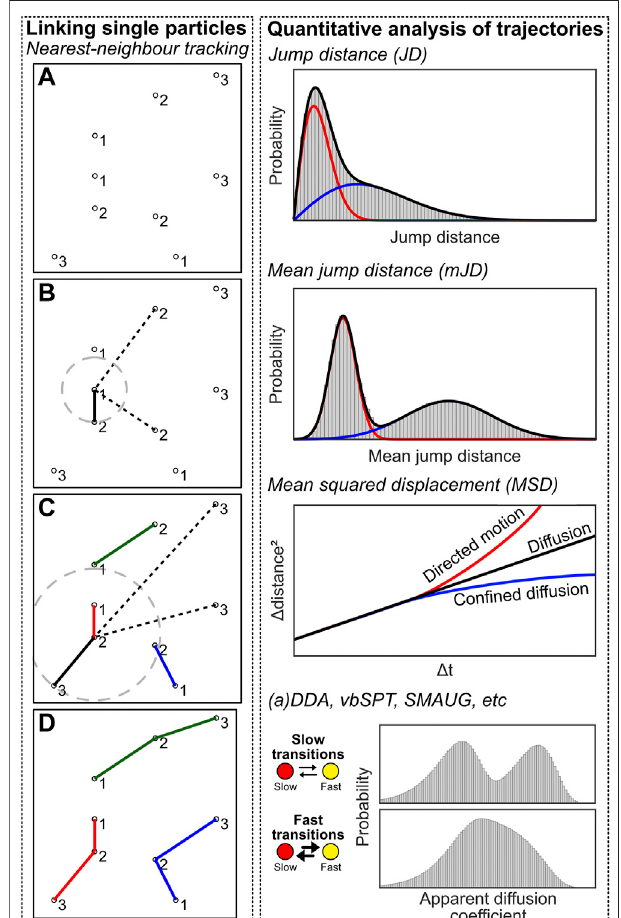
FIGURE 7 | Single-particle tracking computational approaches. Left: Individual emitters have to be linked to create trajectories. Individual emitters have been localized at multiple frames (A) , and the nearest neighbour localization in frame n+1 is determined for every localization at frame n, and a linkage is created between these localizations (B,C) . This creates trajectories that can be further analysed (D) . Right: quanti fi cation analysis of trajectory data. See the main text for details on the